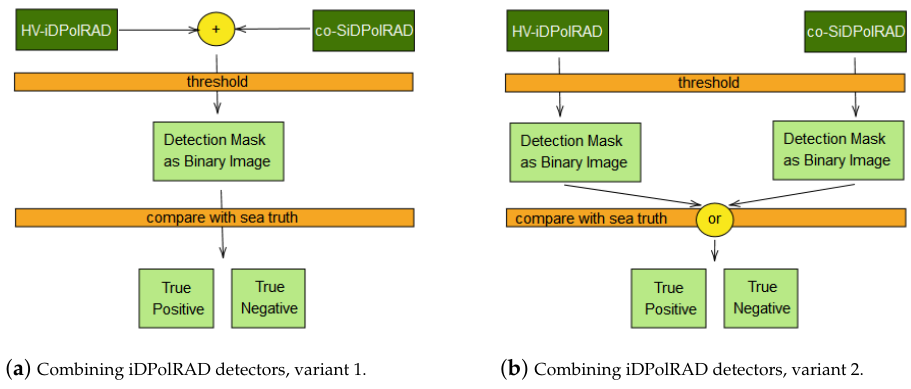
Figure 3. New combinations of the polarimetric detectors Cross-iDPolRAD (volume detector) and Co-SiDPolRAD (surface